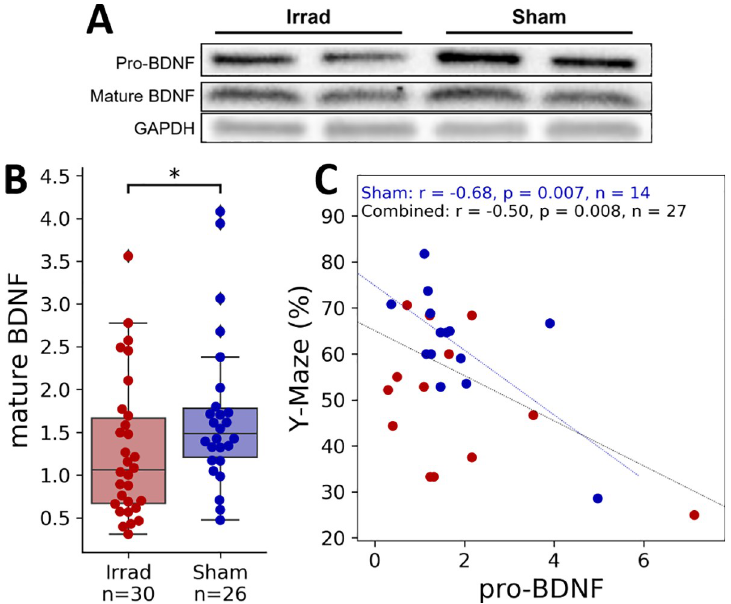
Fig 4. BDNF levels. BDNF levels were measured in mouse whole brain lysates via Western Blot analysis three days after irradiation and one day after Y-maze or open field testing. (A) Representative bands from a Western blot for mBDNF, proBDNF, and GAPDH (all raw Western blot images used for densitometric analysis were included in S6 Fig). (B) Densitometric analysis results of mBDNF normalized the loading control, GAPDH. (C) Correlation between measured proBDNF levels and spontaneous alternation in the Y-maze. � p <